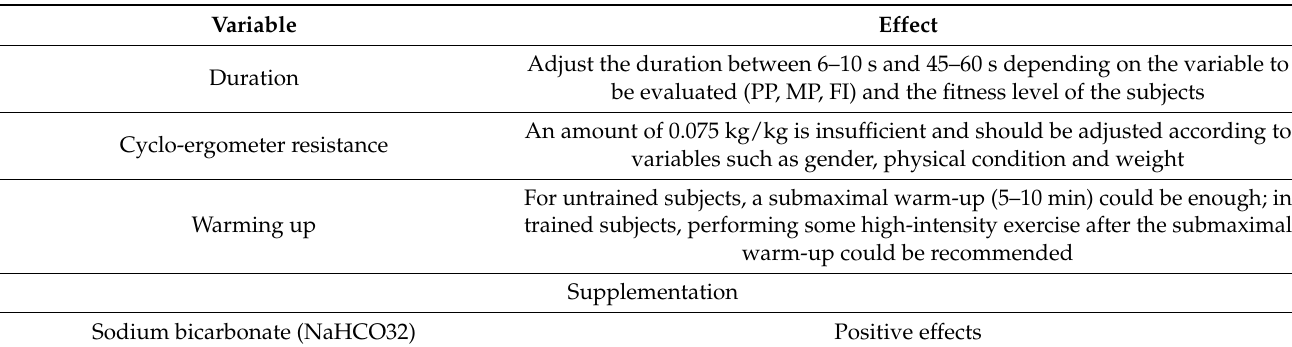
Table 1. Summary of the most important variables reviewed and their effect on the WAT. PP: Peak Power; MP: Mean Power; FI: Fatigue